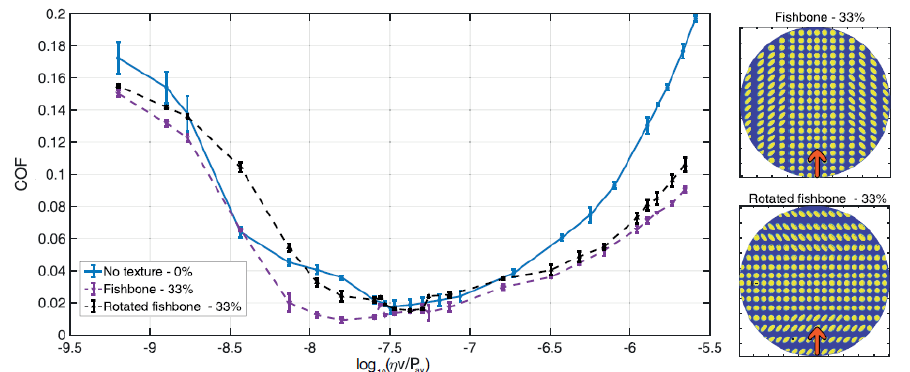
( η v / P av ) for the 10